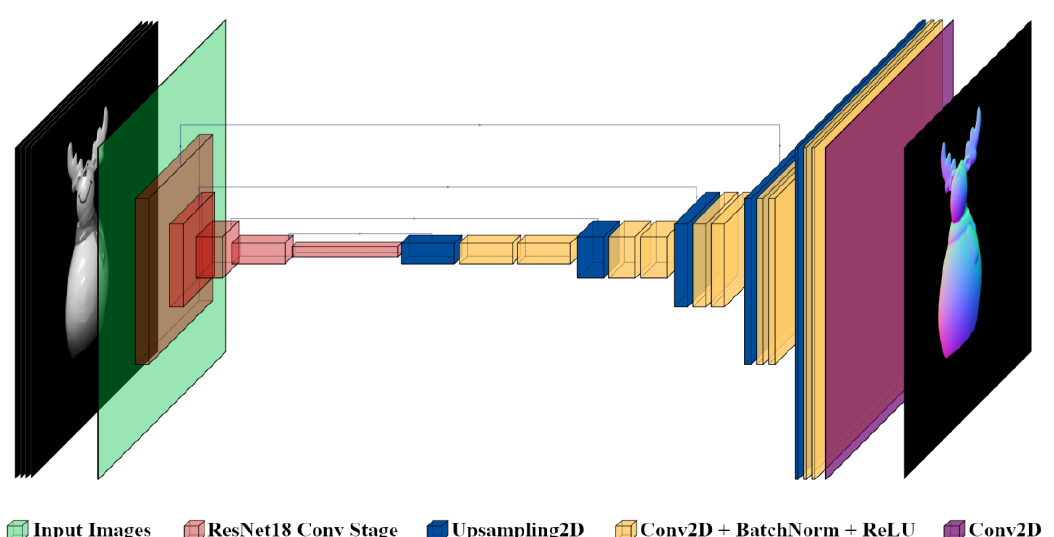
Figure 3 . The overview of the